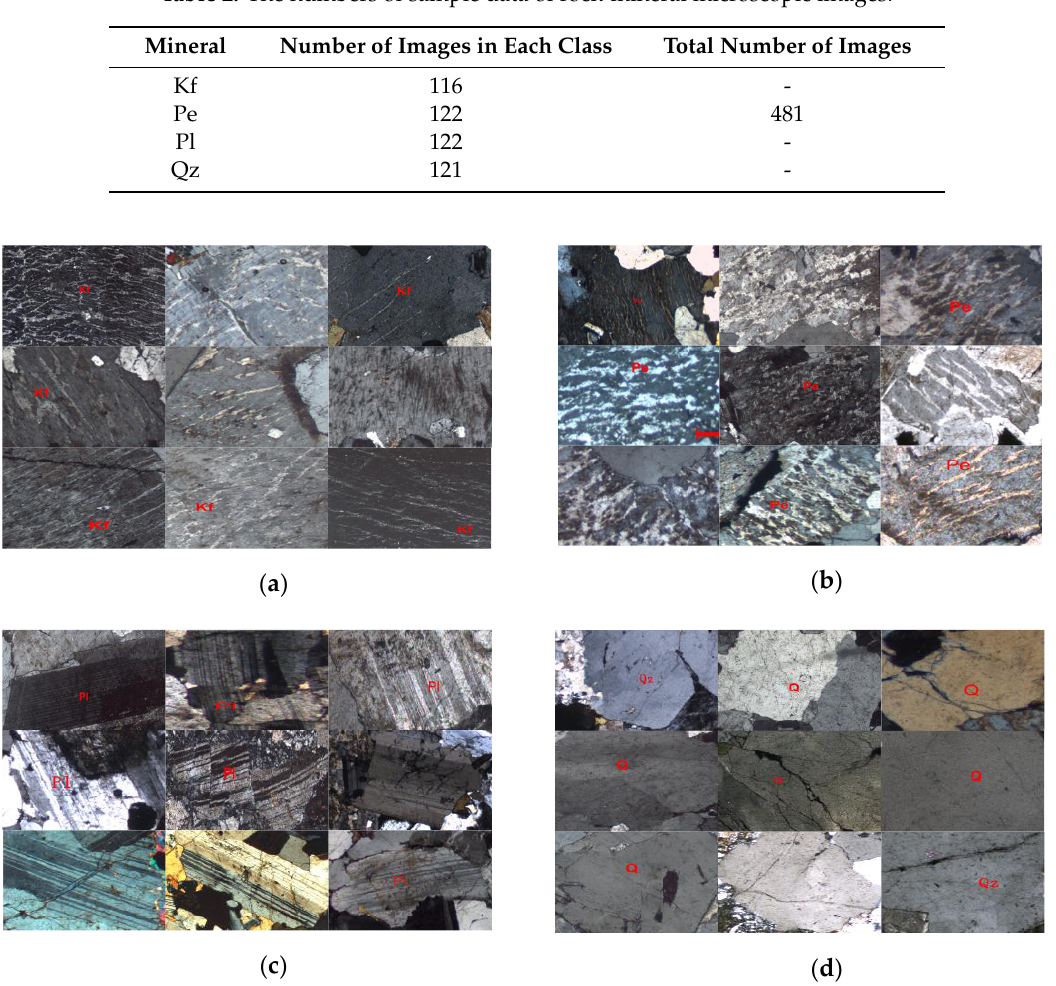
Figure 7. The four cut mineral microscopic images : ( a ) Kf ; ( b ) Pe; ( c ) Pl; ( d ) Qz. Table 2. The numbers of sample data of rock-mineral microscopic images.